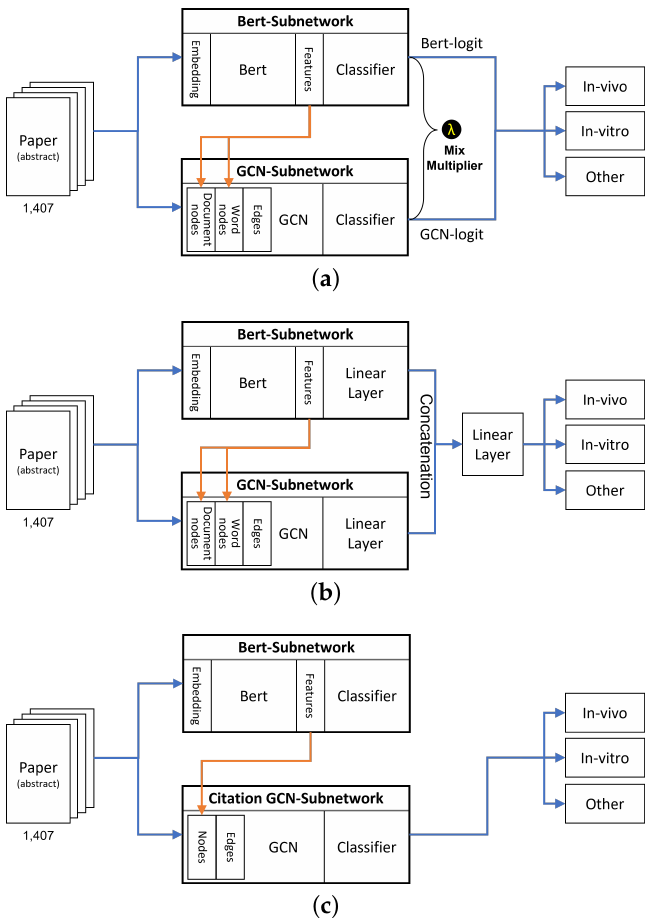
Figure 1. Three modes of GCN-based document classification. ( a ) Statistical GCN (BertGCN). The multiplier lambda adjusts the trade-off between the two objectives, where λ = 1 corresponds to the full BertGCN model and λ = 0 corresponds to using only the BERT module [19]; ( b ) Statistical GCN (BertGCN) without λ . Concatenating the output of both models replaces the mixture process with linear layers, which eliminates the need for the mixing parameter λ and simplifies the neural network architecture; ( c ) citation-based GCN. This model constructs a citation graph using the 396 papers and their corresponding citation